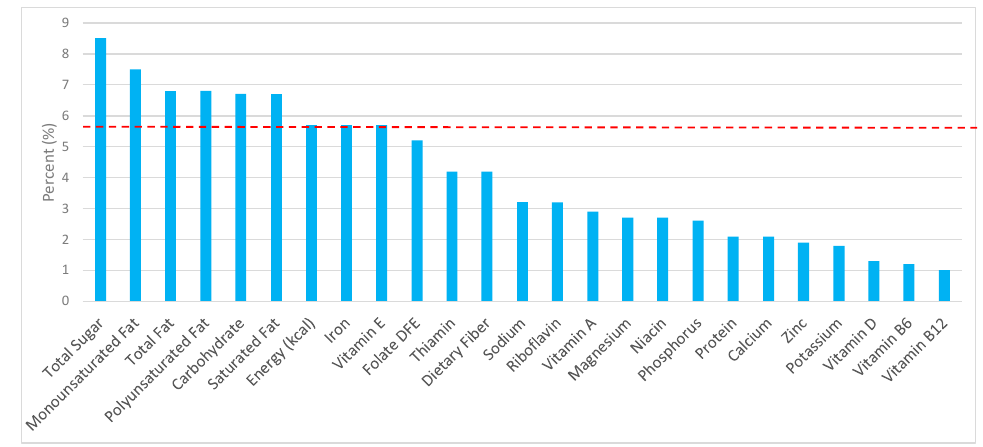
Figure 11. Quick breads and bread products as sources of energy and nutrients using NHANES 2009– 2012, for adult males. Data are for adult males aged ≥ 19 years of age ( n = 5348), Day 1 intakes; dashed red line represents the percentage of energy provided and nutrients that surpass energy (kcal) contribution. Thus, nutrients above the dashed red line show the food category provides a greater percentage in the diet to showcase meaningful nutrient density in the diet per day.